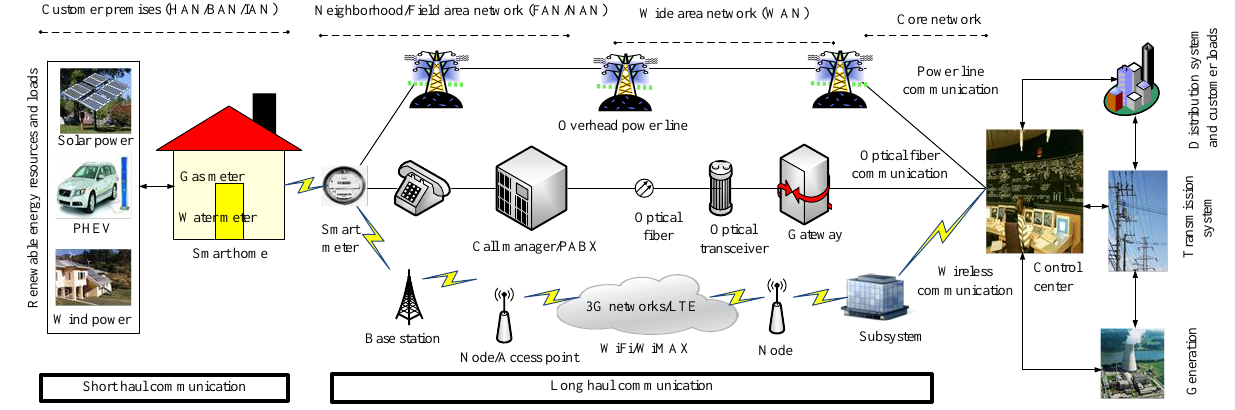
Figure 3. Different communication standards and protocols of a smart